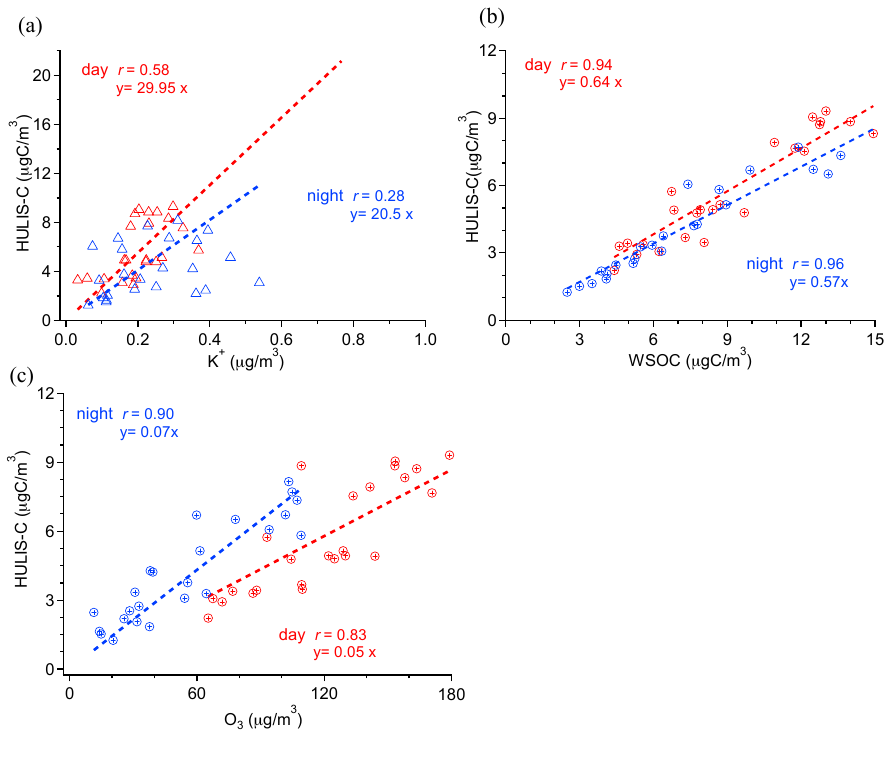
Figure 5. Scatter plots of ( a ) HULIS-C vs. K + ; ( b ) HULIS-C vs. WSOC; and ( c ) HULIS-C vs. O 3 (red for daytime, blue for nighttime).